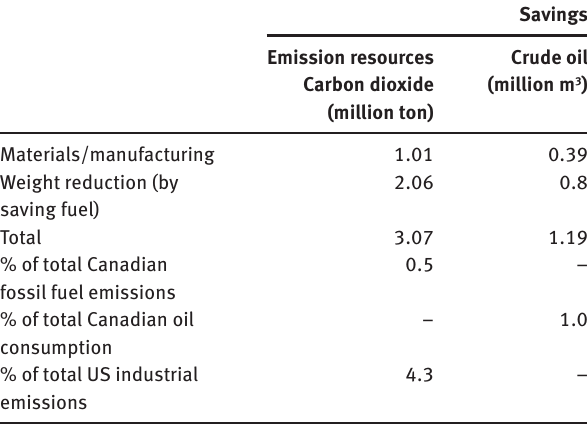
Table 6: Annual potential savings in CO able resources by replacing 50% glass fiber composites with natural fibers in auto sector applications [39].